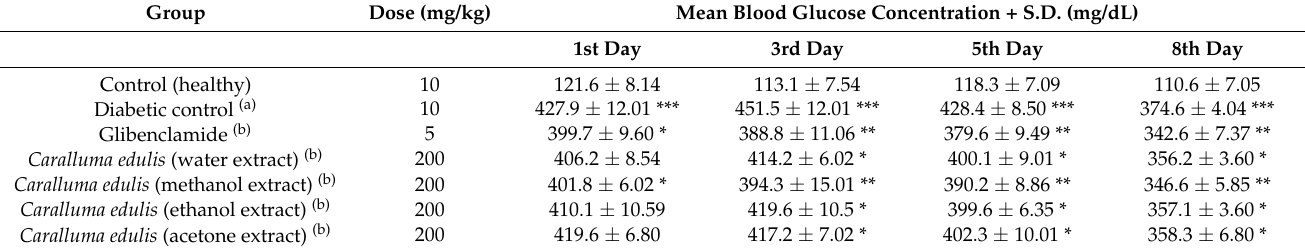
Table 8. Subacute effect of Caralluma edulis extracts on blood glucose levels in alloxan-induced diabetic